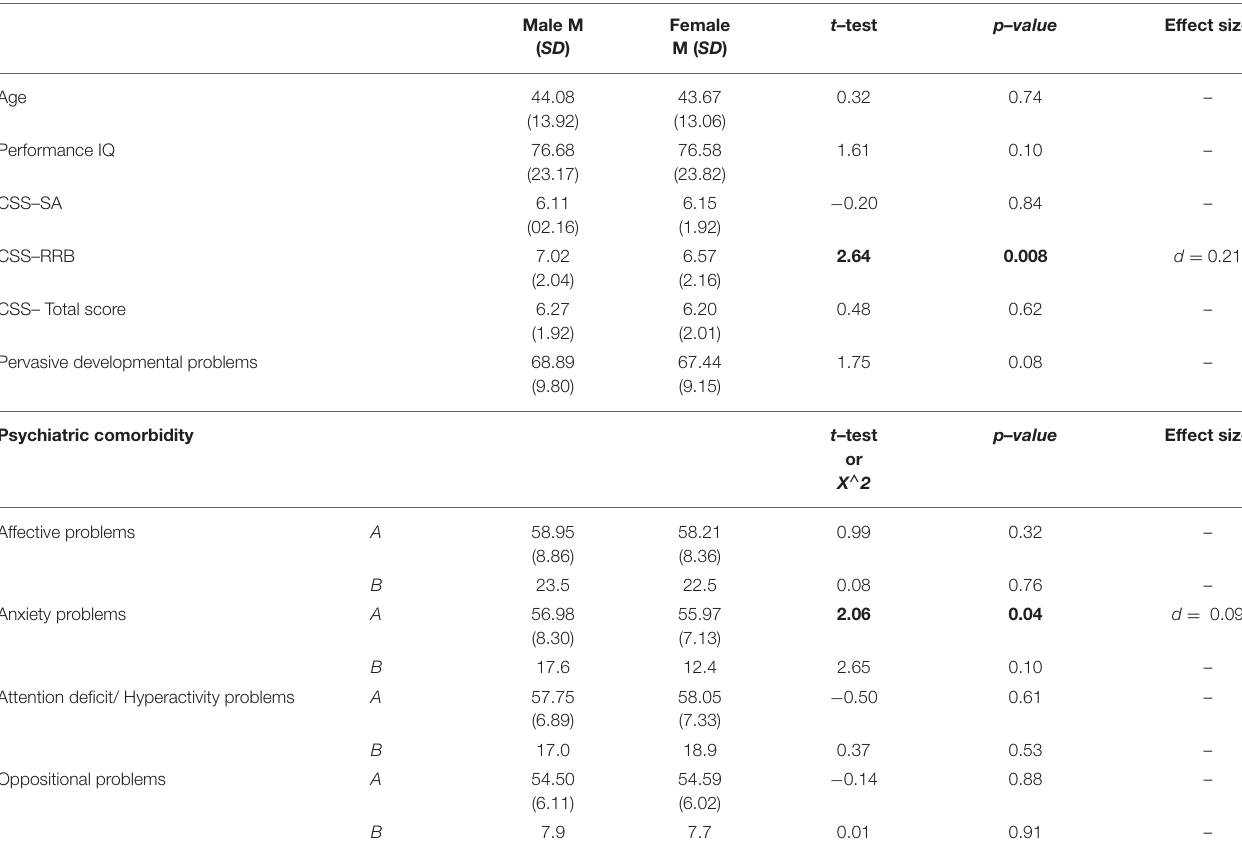
TABLE 6 | Gender differences: comparison of clinical characteristics and of PC in male vs.